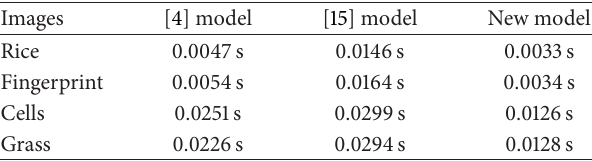
Table 1: Computational cost of [4, (14)], [15, (2)], and